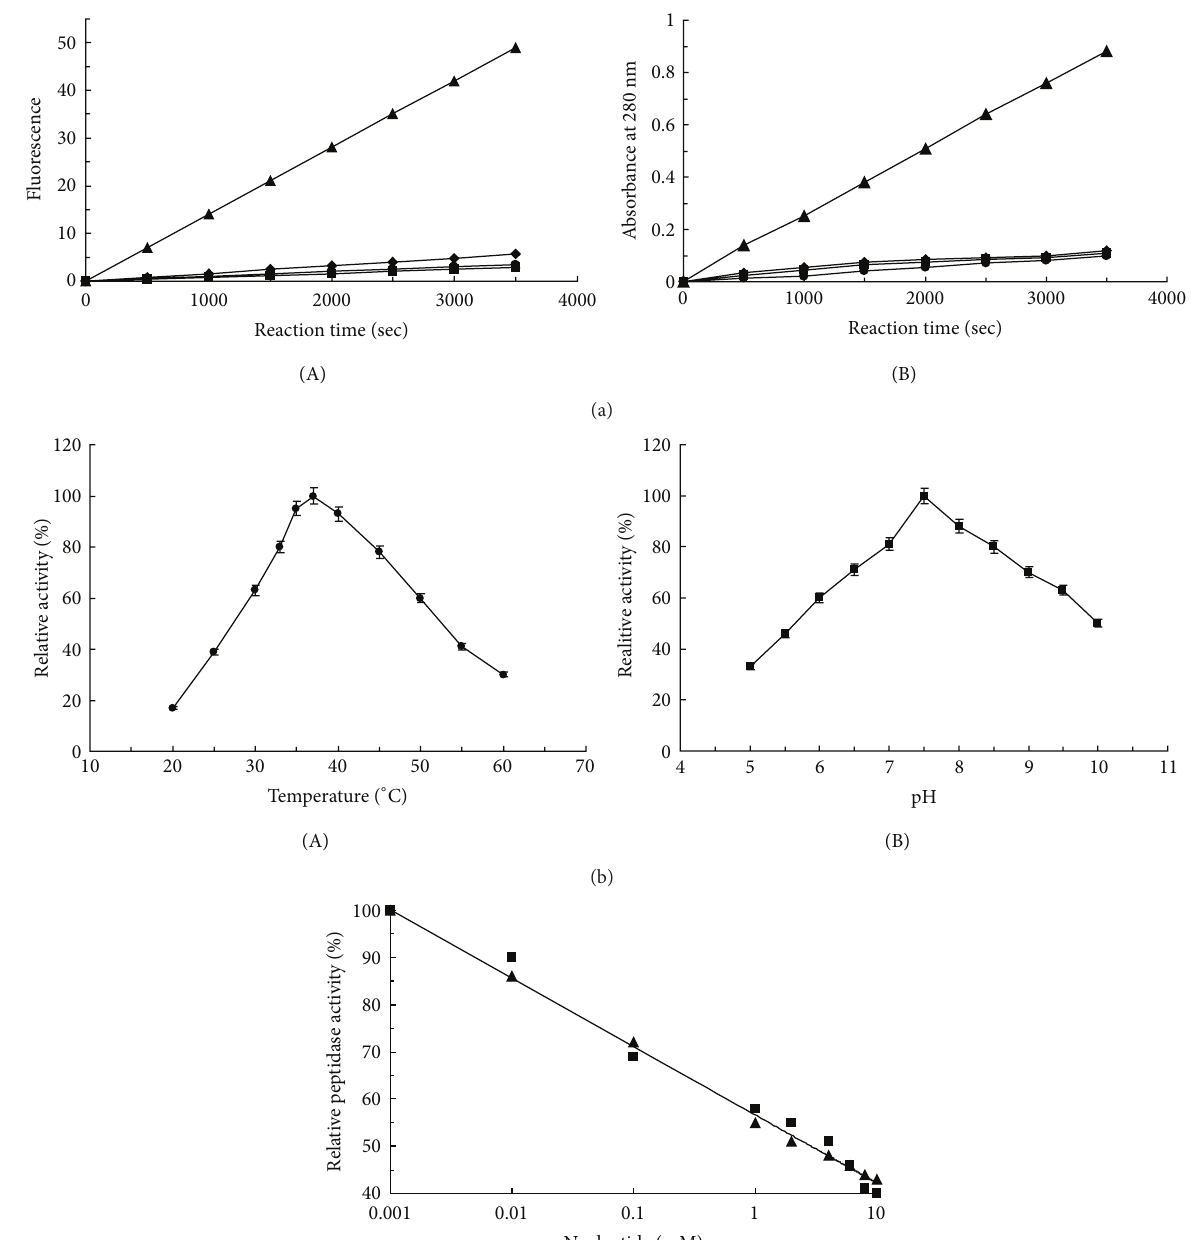
Figure 3: Lon-like-Ms activity assay. (a) Time courses of fluorogenic peptide (A) and 𝛼 -casein (B) hydrolysis by Lon-like-Ms. Reactions were conducted in 50mM Tris-HCl buffer (pH 8.0) containing 5 𝜇 g of Lon-like-Ms and 0.3 mM Glt-AAF-MNA at 37 ∘ C. ATP and/or MgCl 2 were added to the mixture as follows: 4mM ATP and 10mM MgCl 2 (filled triangle); no addition (filled quadrangle); 10 mMMgCl 2 (filled cycle); or 4mM ATP (filled diamond). (b) Effects of temperature (A) and pH (B) on the peptide cleavage activity of Lon-like-Ms. Glt-AAF-MNA was used as a substrate for the peptide cleavage assay. (c) Effects of ATP (filled triangle) and AMP-PNP (filled quadrangle) concentrations on the peptide cleavage activity of Lon-like-Ms.